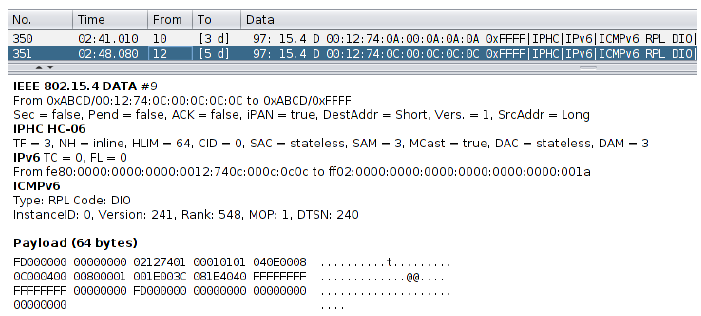
Figure 11. Version number attack simulation. DIO message information.